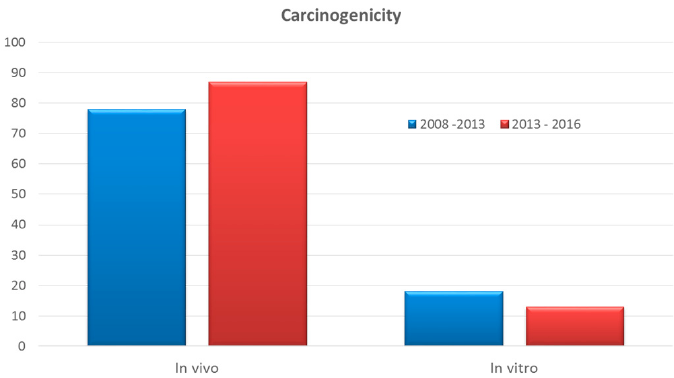
Figure 7. Evolution of the percentage of studies performed in vivo and in vitro to evaluate potential carcinogenicity of cosmetic ingredients—number of studies 26 (2008–2013) and 16 (2013–2016)